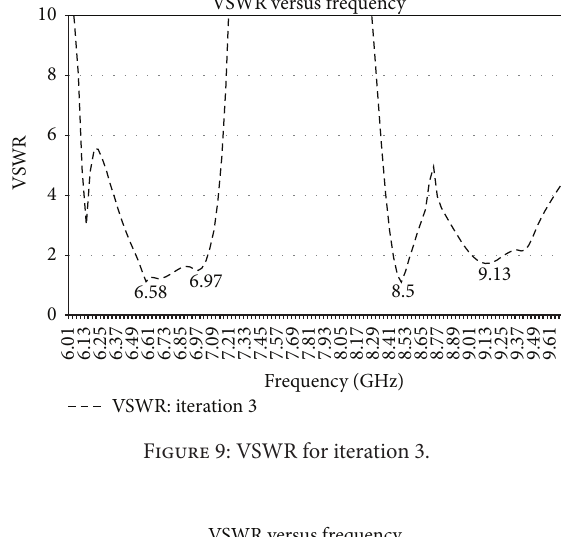
Figure 9: VSWR for iteration 3.